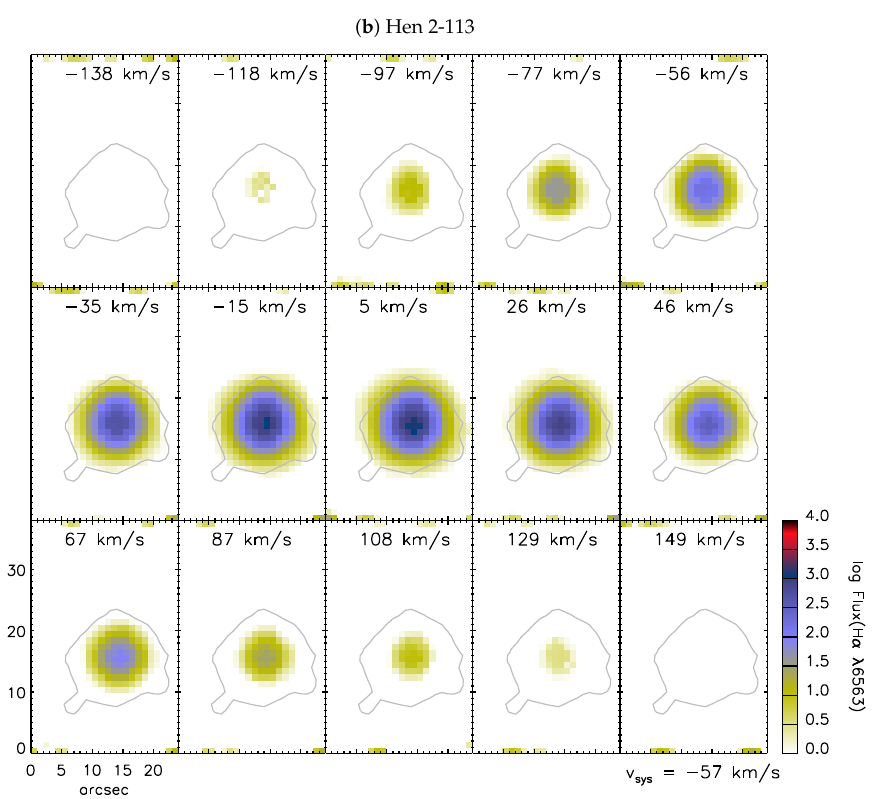
Figure 2. The same as Figure 1, but for ( a ) Hen3-1333 and ( b ) Hen2-113. Figure 3 depicts the position-velocity (PV) arrays of Hen 3-1333 (top panels) and Hen 2-113 (bottom panels) observed in the H α λ 6563 emission, which were generated with two slits with different orientations: one parallel with (left panel), and another one perpen- dicular to the symmetric axes of the primary orientations (right panel). The main on-sky orientations of the PN Hen 3-1333 and Hen 2-113 determined by Danehkar and Parker [27] have position angles (PA) of − 15 ◦ and 65 ◦ , respectively, which are adopted for the slit directions. The slits of each object were positioned on the central star. The continua in the PV arrays were also detected and subtracted in a way similar to the continuum-subtraction performed in the velocity channel maps. The position and velocity axes are with respect to the central star’s location and the object’s systemic velocity, respectively. As can be seen, the faint outflows extending from the central nebulae may get as far as projected velocities of ∼ 100 km s − 1 similar to the channel maps shown in Figure 2, while they are also extended to a radial distance of ∼ 4 (cid:48)(cid:48) from the central stars. Moreover, the tenuous lobes might be extended to ∼ 8 (cid:48)(cid:48) , where the nebula emission is extremely weak for detection. Asymmetric patterns seen in the horizontal slits in both of them, but rather symmetric patterns in the vertical slits, also indicate that the faint outflows have inclinations relative to the line of sight. The inclination angles of i = − 30 ◦ and 40 ◦ were also suggested for Hen 3-1333 and Hen 2-113 [27]. Detection of substructures of these compact objects require spatial and velocity resolution higher than the